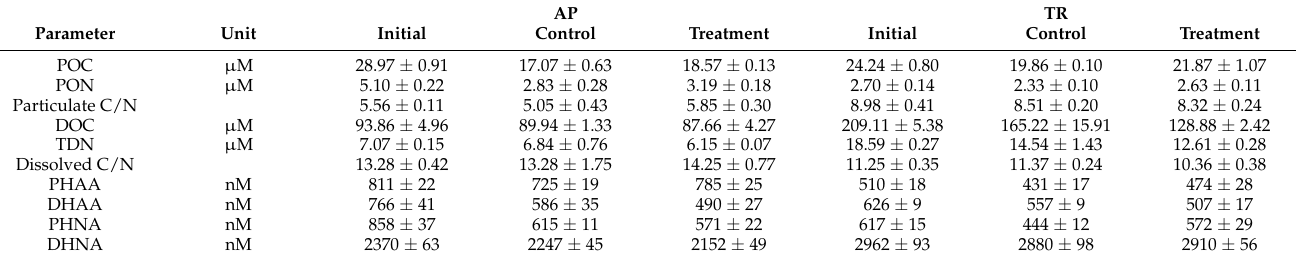
Table 1. Aggregation of organic characteristics. Abbreviations: POC: particulate organic carbon; PON: particulate organic nitrogen; DOC: dissolved organic carbon; TDN: total dissolved nitrogen; PHAA: particulate hydrolysable amino acid; DHAA: dissolved hydrolysable amino acid; PHNA: particulate hydrolysable neutral aldose; AP: coastal Avery Point site; TR: estuarine Thames River site. Initial denotes the field data; treatment denotes samples after two days of rolling; and control denotes samples incubated for two days without